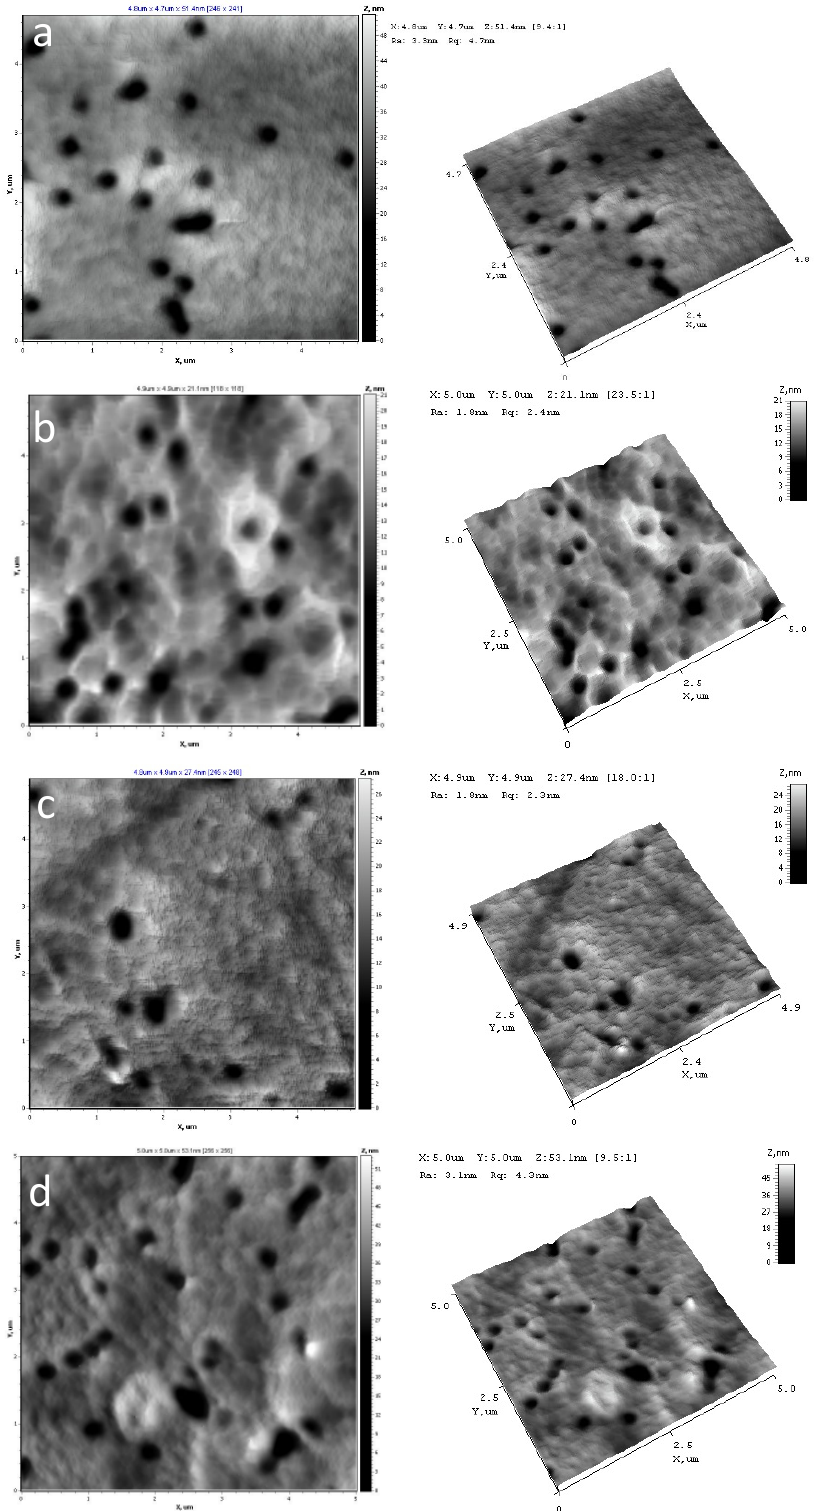
Figure 2. AFM of initial PET TeMs ( a ) and after modification at 15 mM TCOS for 2 h ( b ), 4 h ( c ) and 24 h ( d ). Table 3. Results of atomic force microscopy.